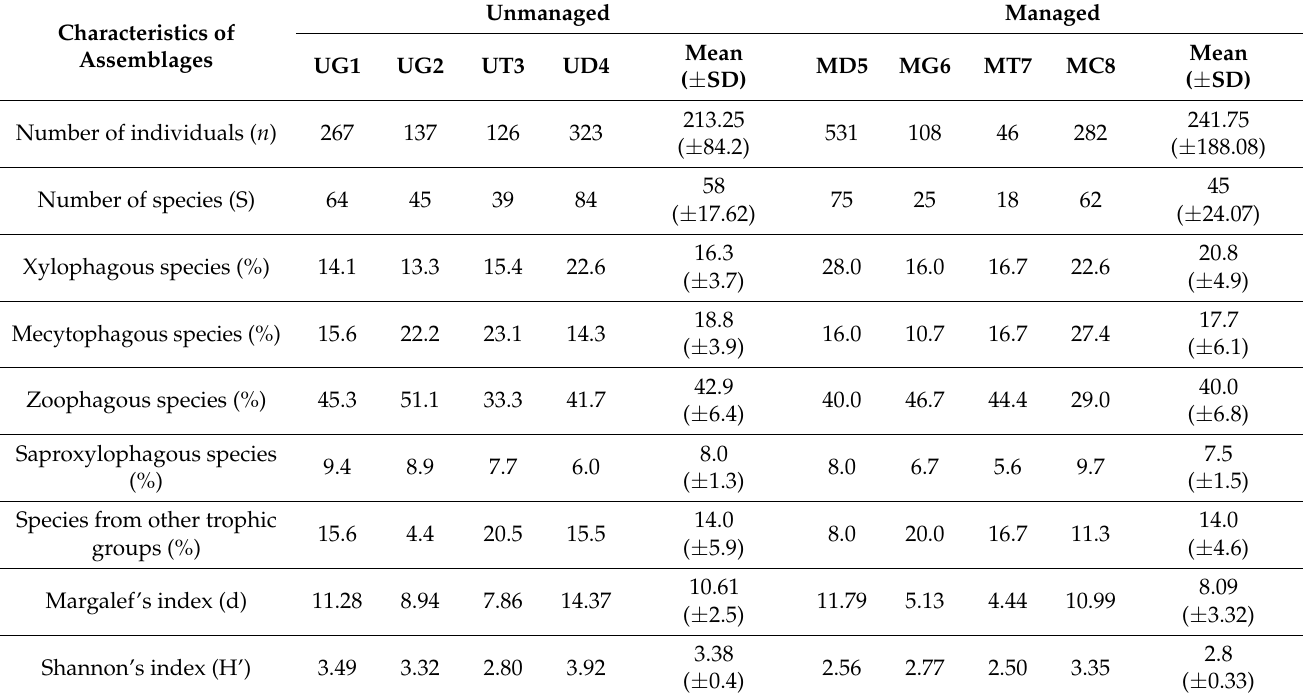
Table 2. Characteristics of Coleoptera assemblages in managed and unmanaged pine stands in western Poland. Characteristics of